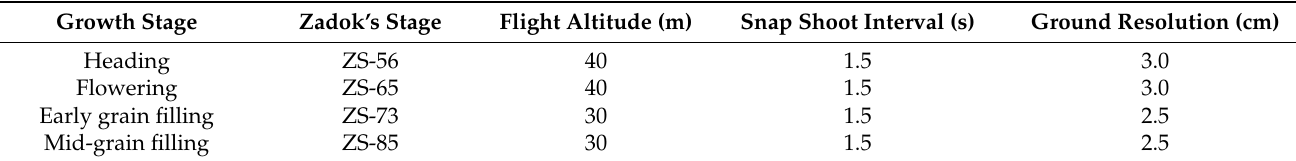
Table 2. Flight details of the unmanned aerial vehicle imagery system.